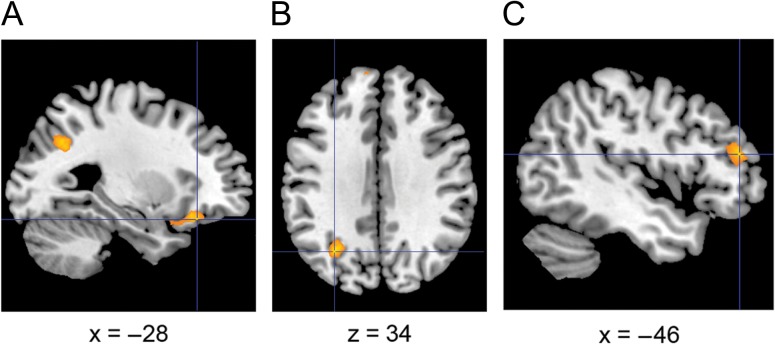
Activation maps showing positive correlation between RS to faces and CFMT scores (covarying out CCMT scores) across all participants in (A) medial prefrontal cortex, (B) left inferior parietal cortex, and (C) left dorsolateral prefrontal cortex. Activation maps are overlaid on a standard anatomical template image (ch2better.nii) using in MRIcron (http://www.mccauslandcenter.sc.edu/mricro/mricron/). All maps are thresholded at t = 3.46, P < 0.001 (10 contiguous voxels).